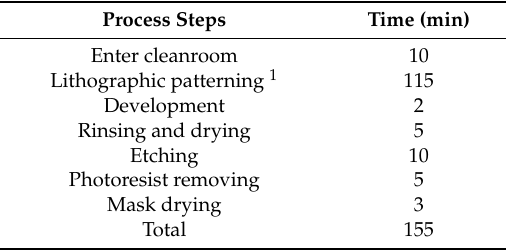
Table 1. The estimated time of fabricating the photomask.